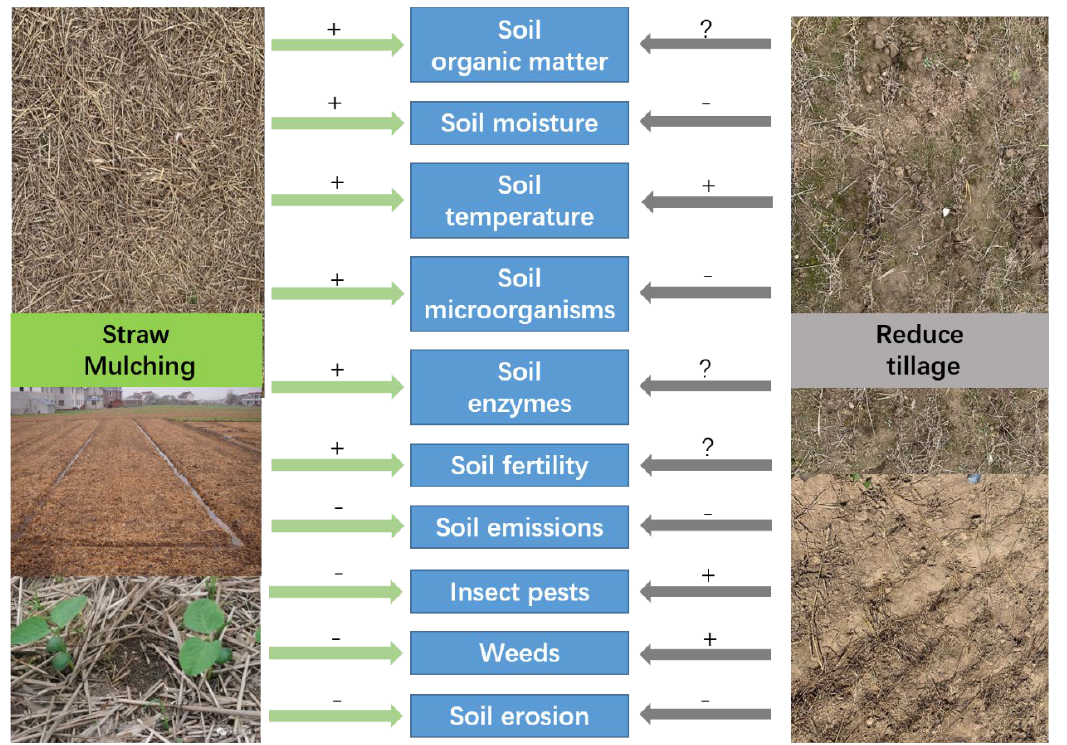
Figure 1. Effects of straw mulching and reduced tillage on the soil environment. The + sign showed a positive effect, the − sign showed the negative effect, and ? indicate the undefined effect.